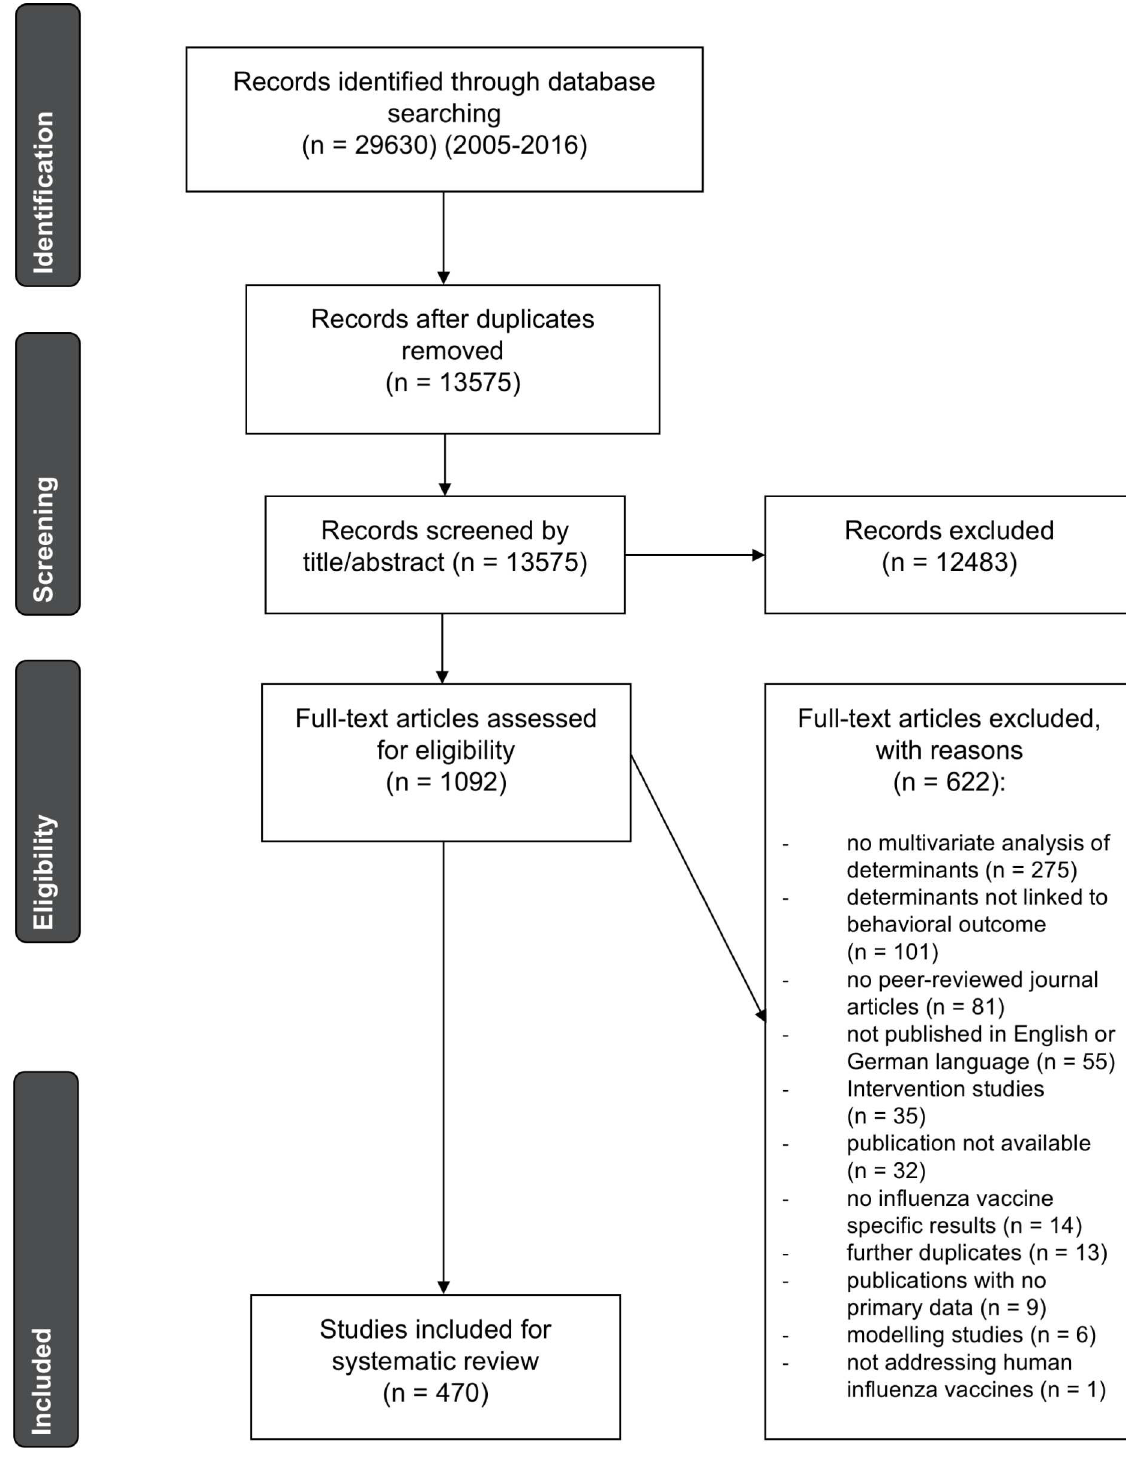
Fig 2. Flow Chart of selection